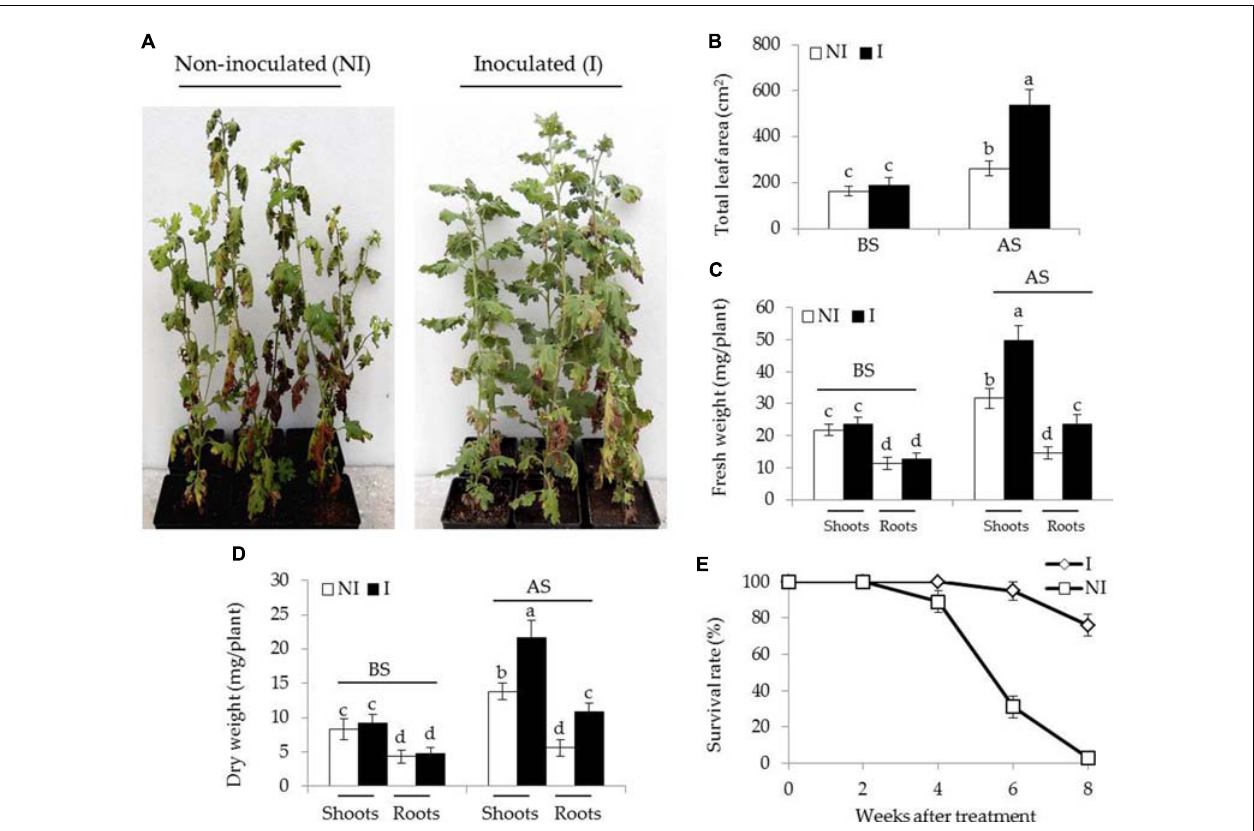
FIGURE 1 | Effects of B. licheniformis SA03 on Chrysanthemum plants under saline–alkaline stress. After 10 days of bacterial inoculation, the non-inoculated (NI) and inoculated (I) were subjected to saline–alkaline treatment for 4 weeks, respectively. The treated plants were used to analyze (A) growth phenotype, (B) total leaf areas (LA), (C) shoot and root fresh weight, (D) shoot and root dry weight, and (E) survival rate. BS, before the stress treatment; AS, after the stress treatment. Data are expressed as the mean values of three replicates ( ± SE) with 10 plants each. Different letters indicate significant differences using two-way ANOVA followed by the Duncan’s multiple range test at P <